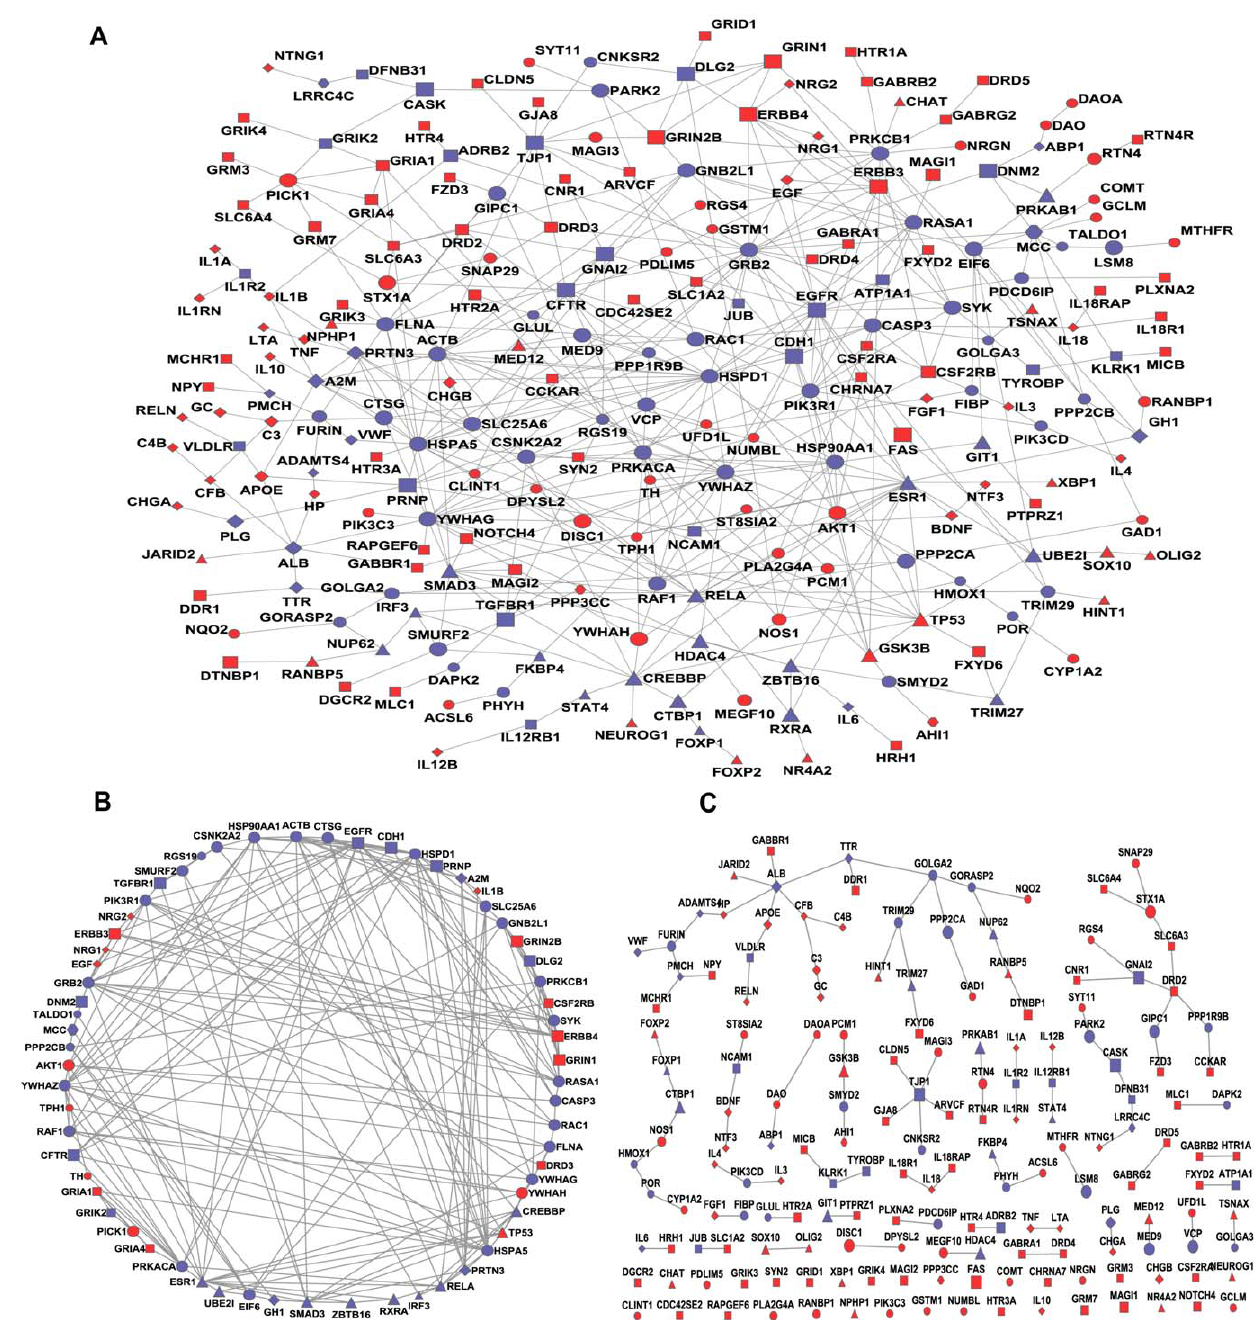
Figure 2. Schizophrenia-specific network. SZGenes are labeled in red and non-SZGenes in blue. Node area corresponds to its degree in the human interactome. Node shape indicates its cellular location: ellipse for cytoplasm, diamond for extracellular space, triangle for nucleus, square for plasma membrane, and hexagon for unknown location. (A) The extracted schizophrenia-specific network from the human interactome. It has 233 nodes and 436 edges. (B) Network for the 63 nodes that could form clusters by CFinder. (C) Networks for the 170 nodes that could not form clusters by CFinder.